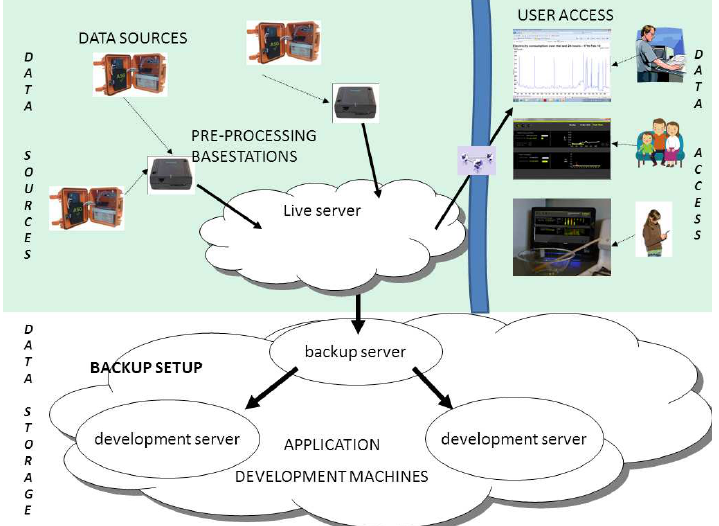
Figure 5. Overview of Data Storage, Backup and Presentation. Multiple landfill sensors can upload data to a single cell base-station. Thereafter these base-stations upload data to a central server, which is also backed up. Finally this data is available via the Internet for end users to access.